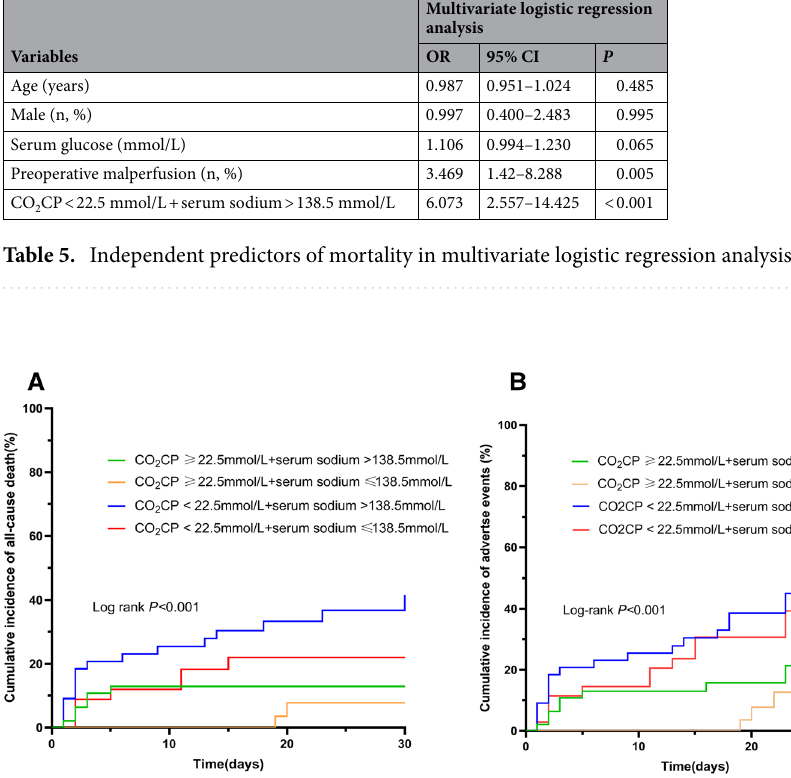
Figure 3. Kaplan–Meier survival curves for cumulative events in different CO 2 CP and serum sodium levels. ( A ) All-cause death; ( B ) adverse